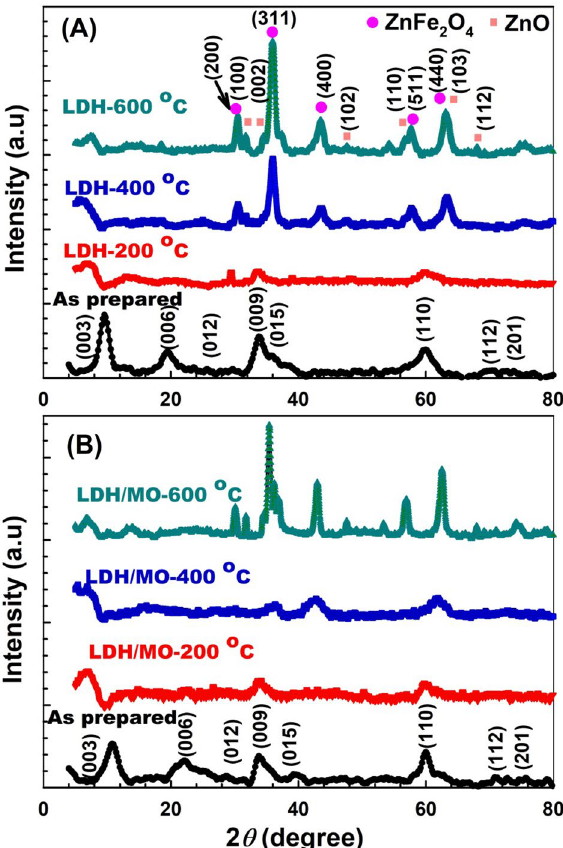
Figure 2. XRD of LDH samples ( A ) before and ( B ) after adsorption of MO.